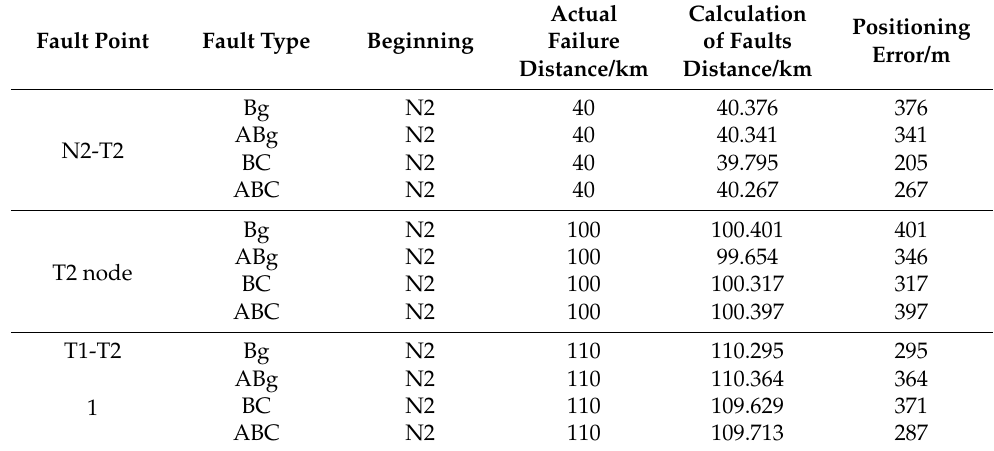
Table 8. The results of reference [20] under different experimental conditions.